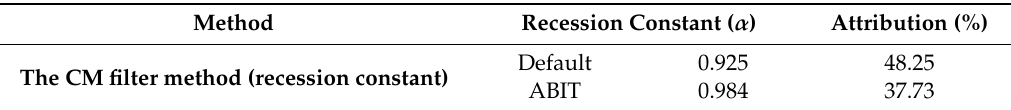
Table 1. Attribution analysis of baseflow using the Chapman–Maxwell method (the CM filter) and the two-terminal mixed water source segmentation model.